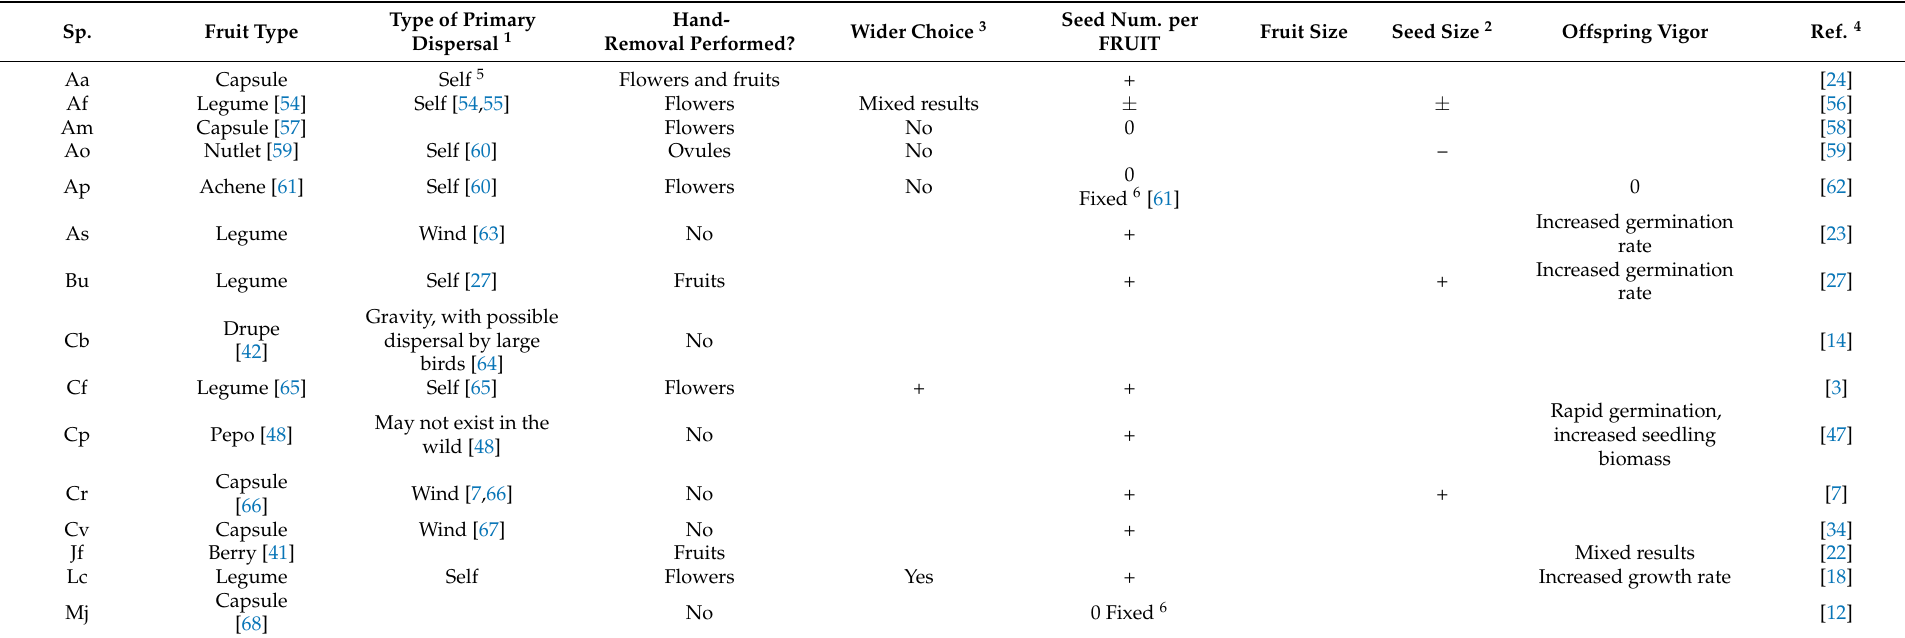
Table 2. A list of species for which selective maturation was investigated (including negative results). A plus sign (+) indicates that the effect of selective maturation increased the value of that trait. For example, for seed number per fruit, a plus sign indicates that maternal plants selectively matured fruits that contained more seeds than aborted immature fruits or ovaries. A minus sign ( − ) indicates that the opposite was found. A plus–minus sign ( ± ) indicates that mixed results were observed. A zero sign (0) indicates that no effect of selective maturation was observed on that trait. A blank cell indicates that no information on that topic was found in our literature survey. Sp. (species codes): Aa: Asphodelus albus Miller (Liliaceae); Af: Anagyris foetida L. (Fabaceae); Am: Agave mckelveyana Gentry (Asparagaceae); Ao: Anchusa officinalis L. (Boraginaceae); Ap: Achillea ptarmica L. (Asteraceae); As: Asclepias speciosa